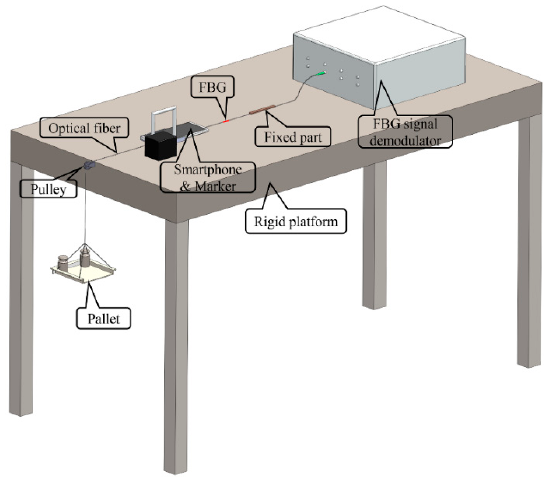
Figure 2. Setup of the test.